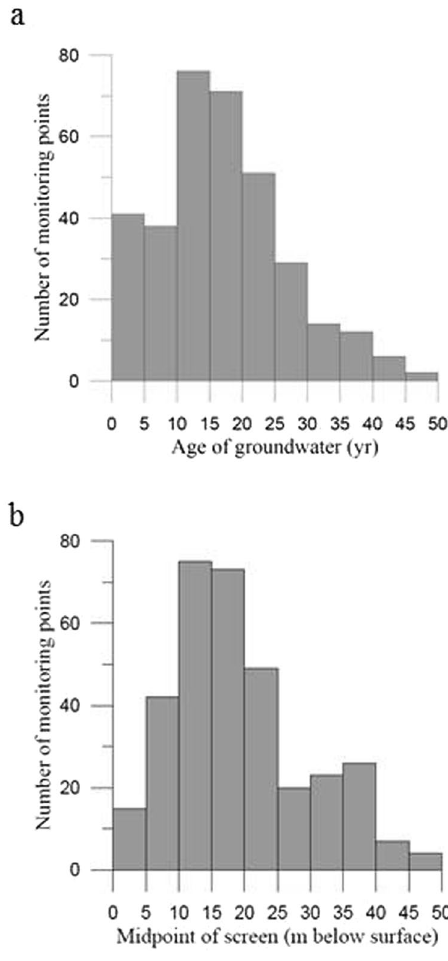
Figure 7. Distribution of the studied 340 monitoring points in Danish oxic groundwater according to the age of the groundwater ( a ) and the depth of the midpoint of the screen in m below surface ( b